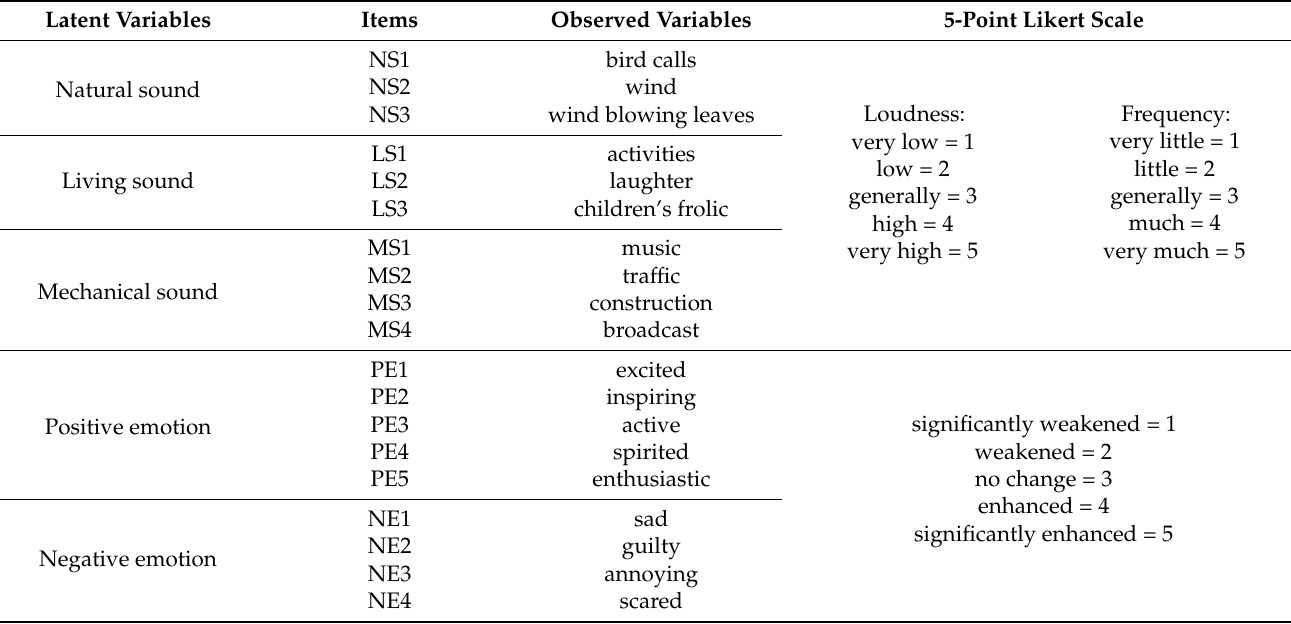
Table 2. Measurement items of latent